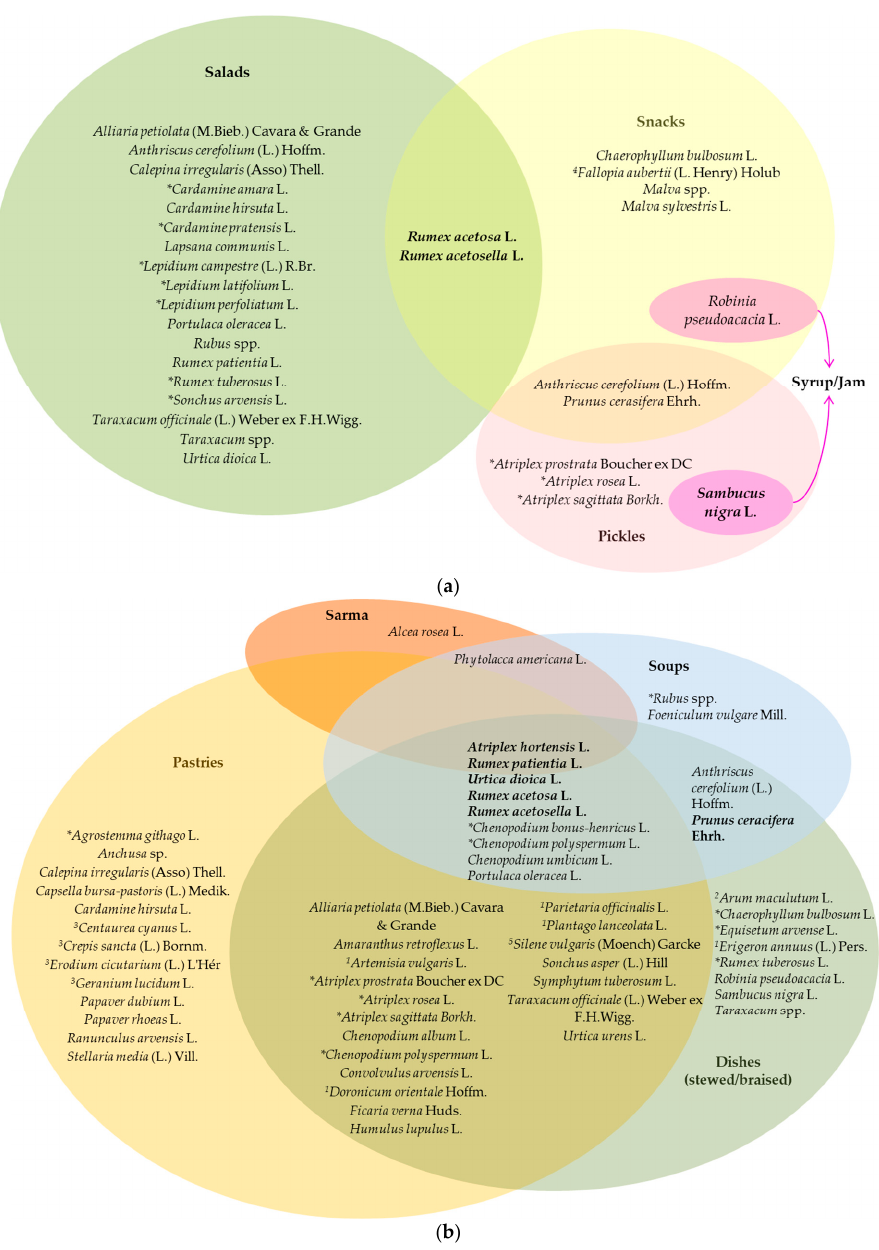
Figure 2. Ruderal plants used as spring food in Bulgaria and their way of consumption: ( a ) raw preparations (salads and snacks) and preserves and ( b ) cooked preparations (sarma category includes dishes made of leaves stuffed with vegetables, cereals with/without meat). Edible plants mentioned in traditional food cookbooks are shown in bold. Taxa from the current research are recorded in the following regions: 1 Blagoevgrad, 2 Sliven, 3 Haskovo, 4 Pazardzhik, and 5 Smolyan. * Species mentioned only in the literature sources.